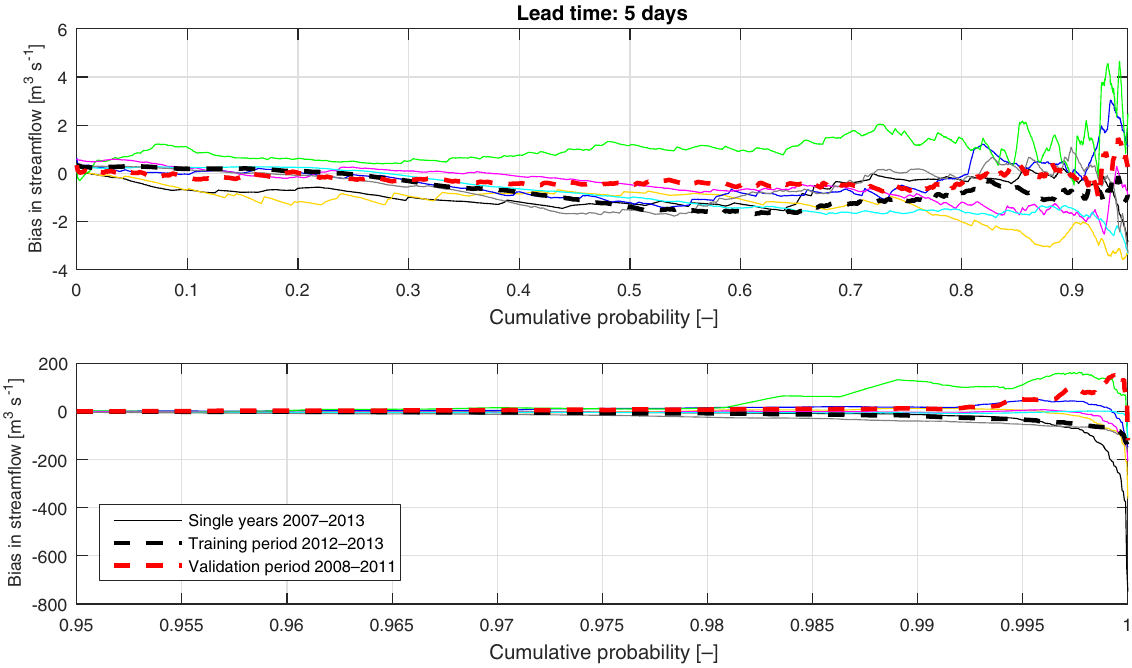
Figure 11. Difference between CDFs of the measurements and CDFs of the uncorrected streamflow forecasts per hydrological year (upper panel cumulative probability: 0–0.95; lower panel: 0.95–1.0). Each thin line refers to a single year between 2007 and 2013. This figure is for a lead time of 5